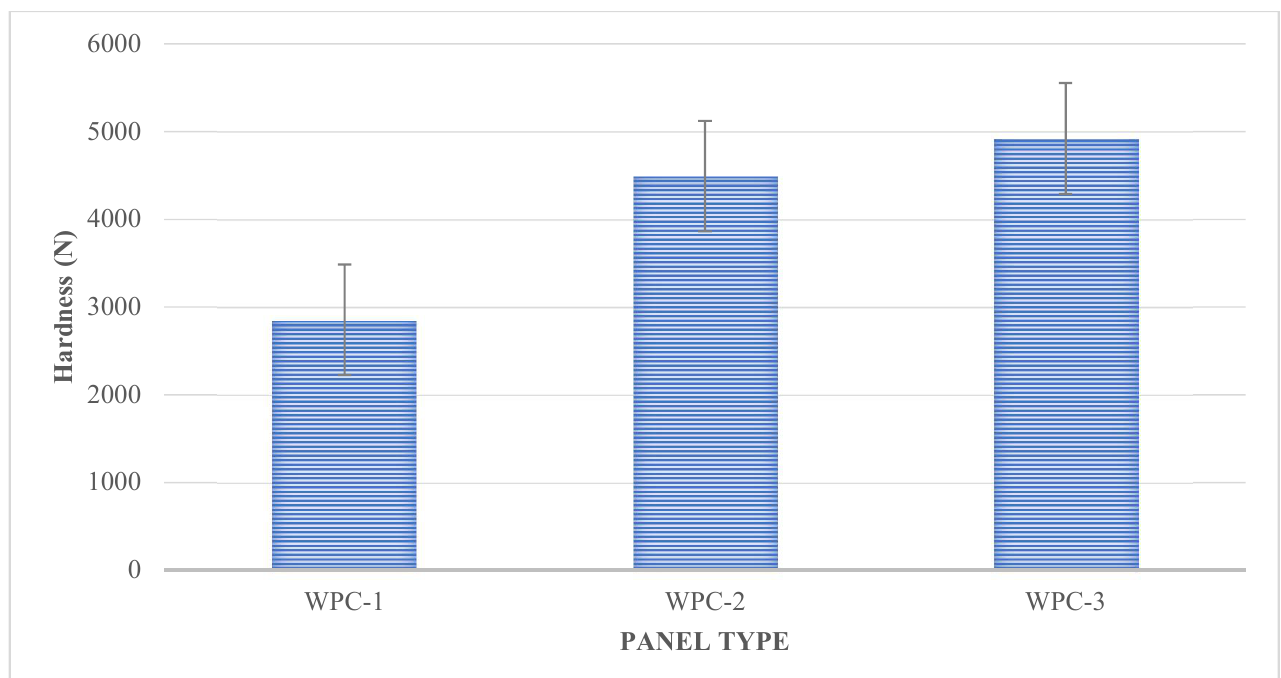
Figure 4. Hardness values of the samples.